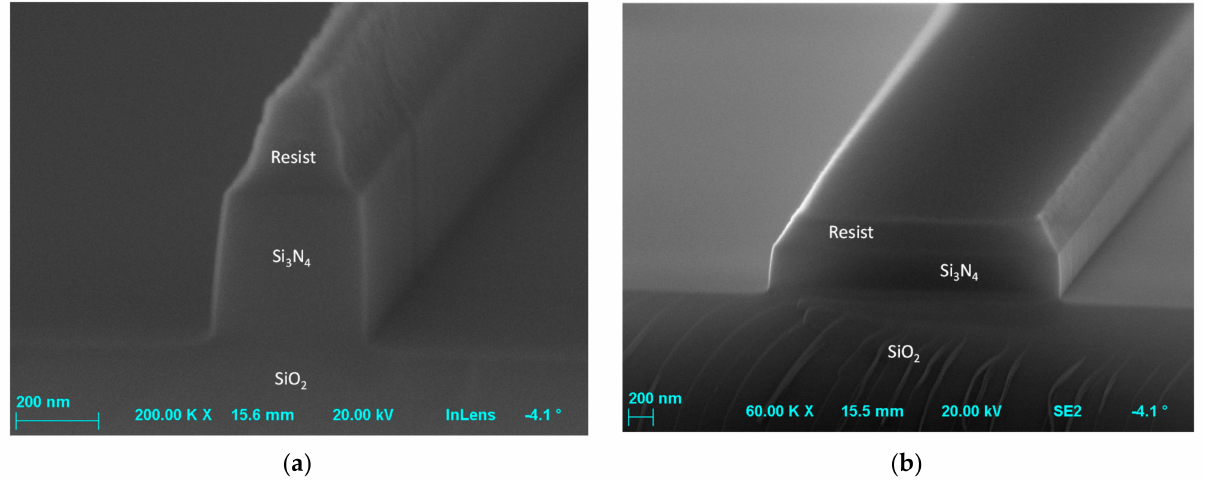
Figure 12. Cross section of exemplary waveguides etched in Si 3 N 4 with remaining top layer of resist mask of width ( a ) 0.36 µ m and ( b ) 2.7 µ